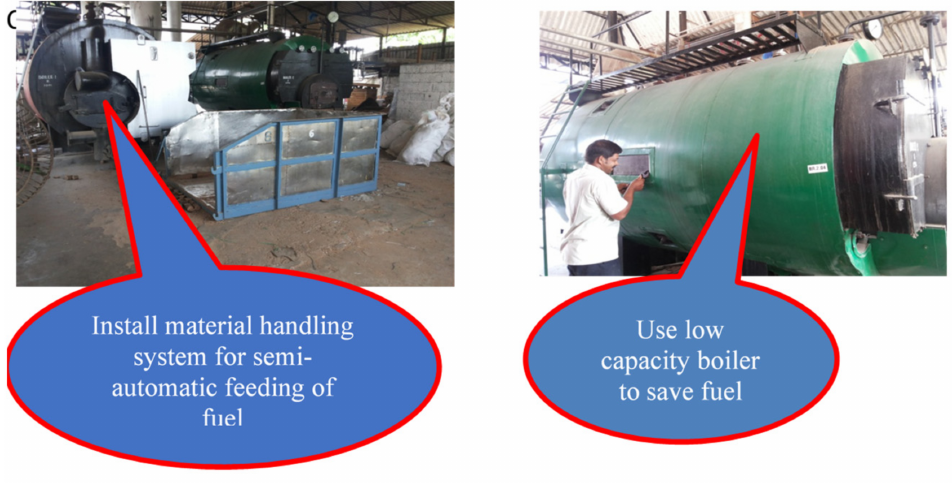
Figure 4. The current situation and suggestion for boiler performance